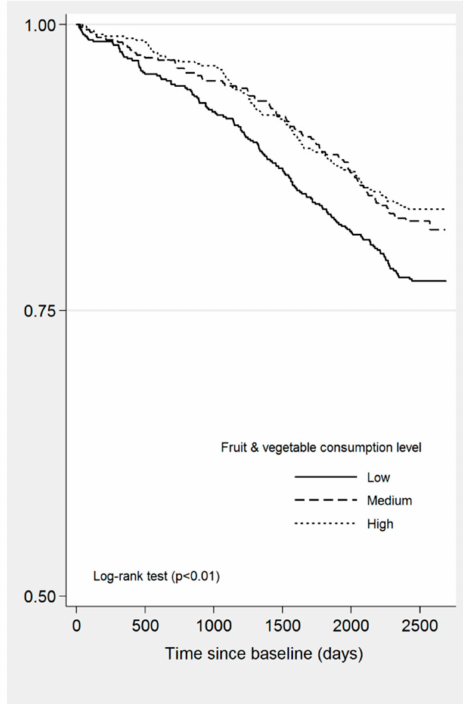
Figure 1. Kaplan–Meier estimated curves for cumulative survival by levels of fruit and vegetable